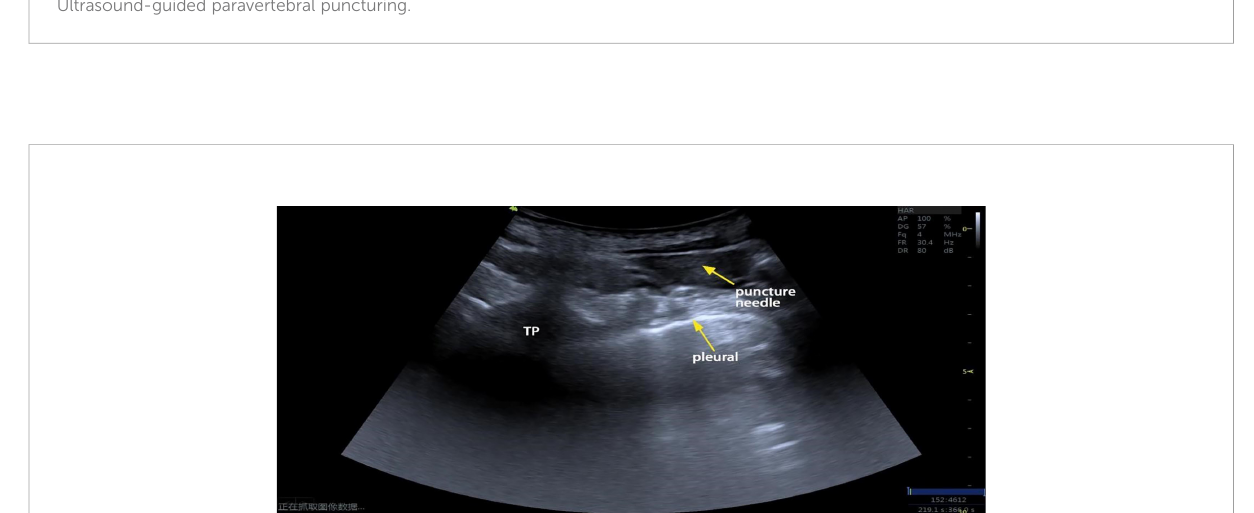
FIGURE 3 Echocardiography of ultrasound-guided TPVB (TP, transverse